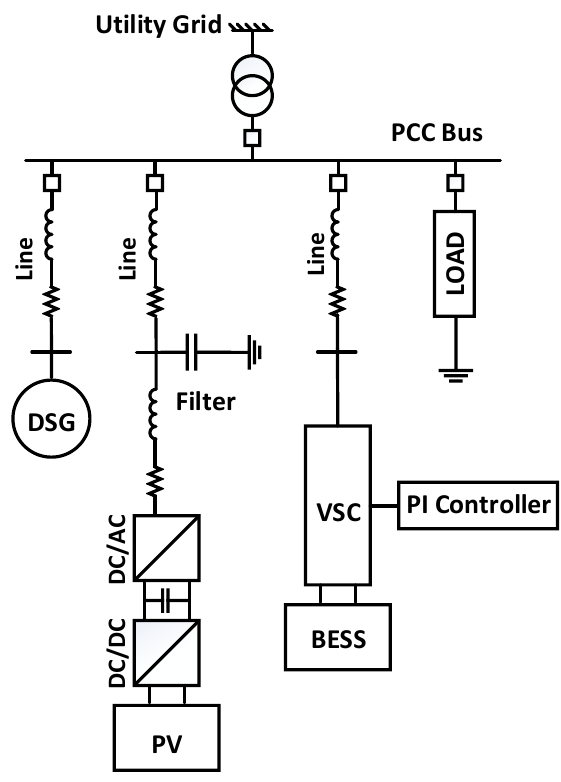
Figure 2. Detailed layout of the MG system.